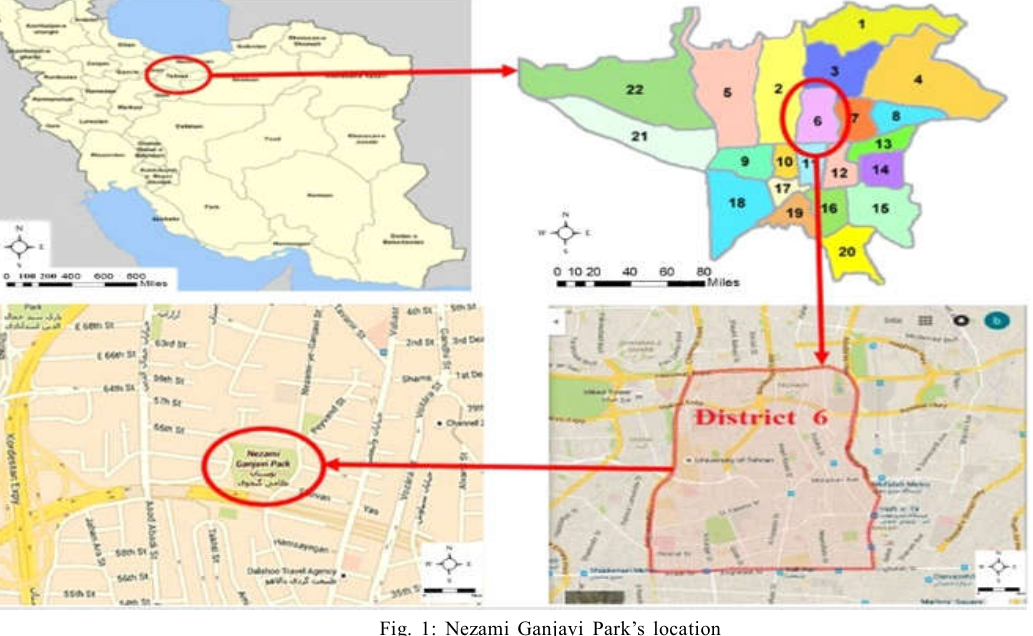
Fig. 1: Nezami Ganjavi Park’s